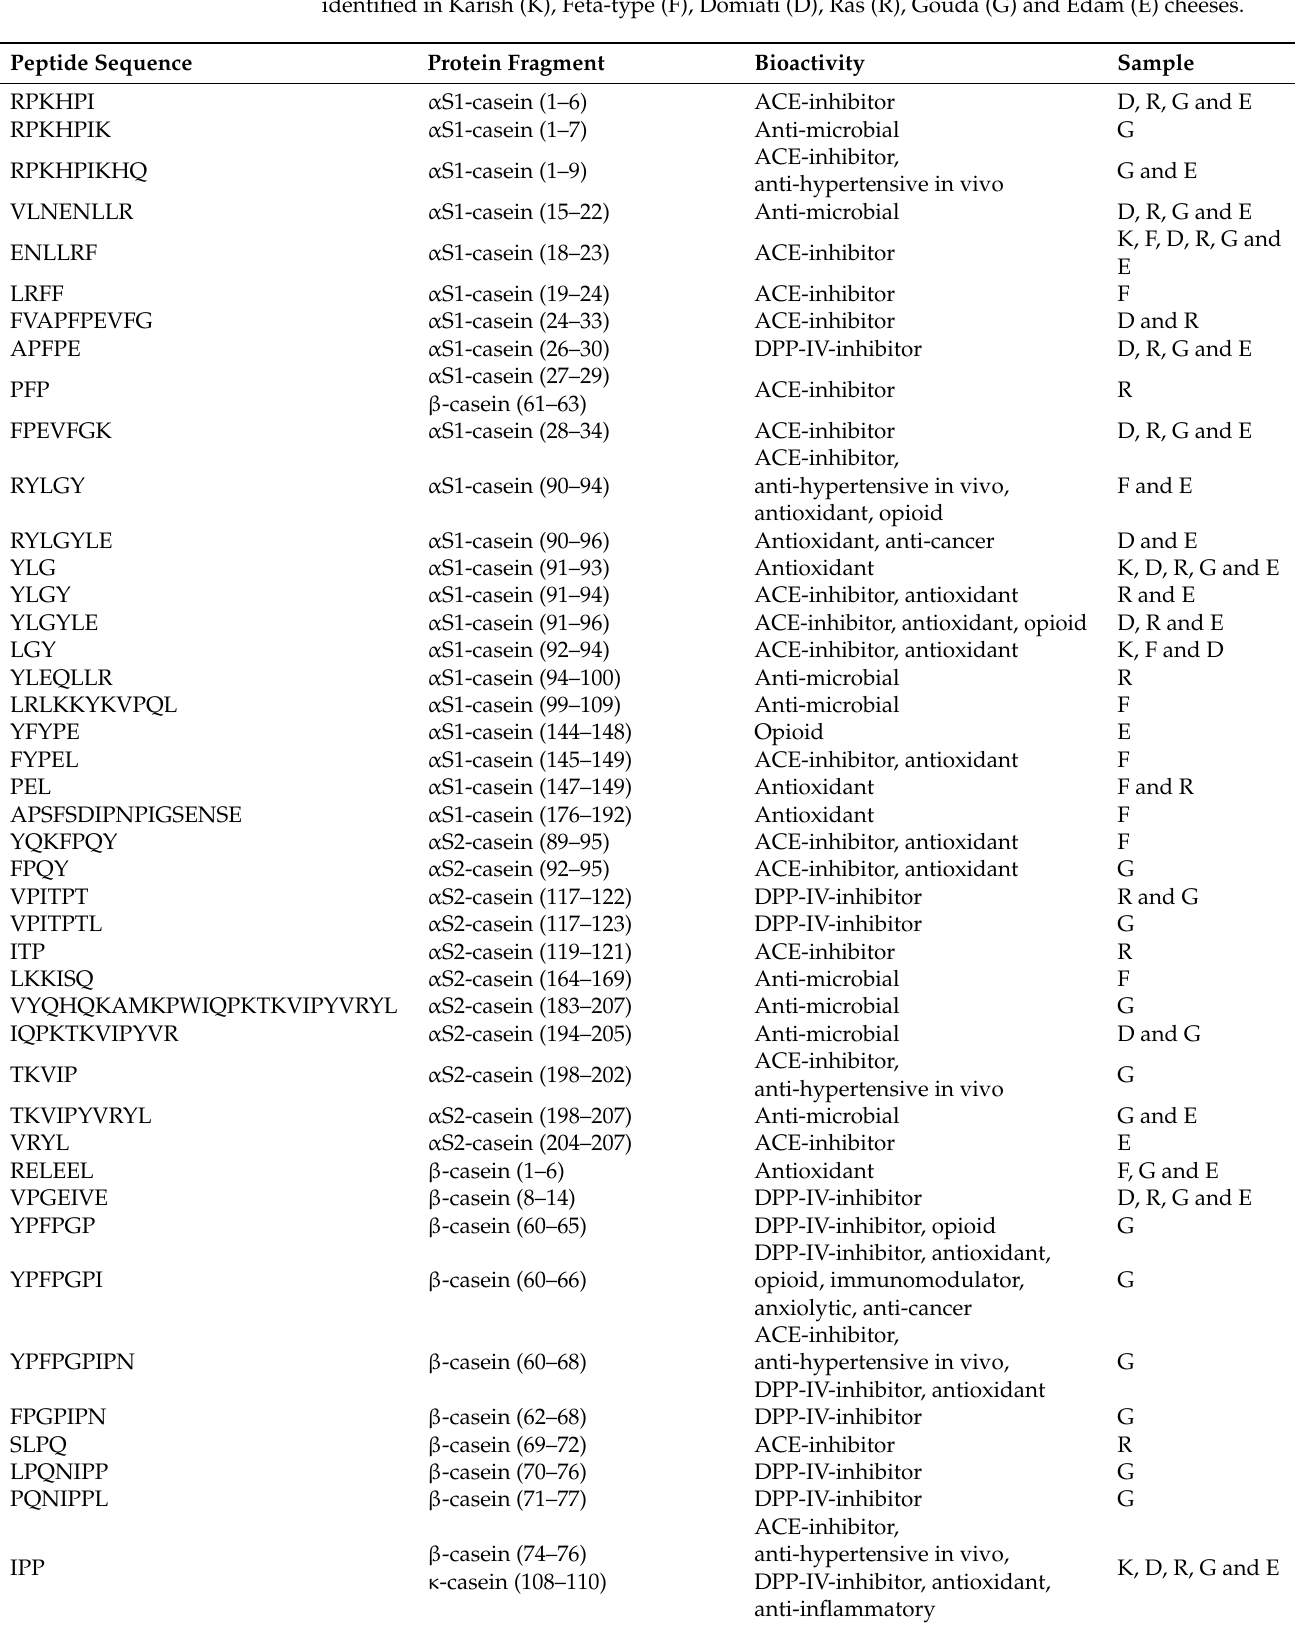
Table 3. Peptides sharing 100% of sequence homology with previously reported bioactive peptides identified in Karish (K), Feta-type (F), Domiati (D), Ras (R), Gouda (G) and Edam (E)